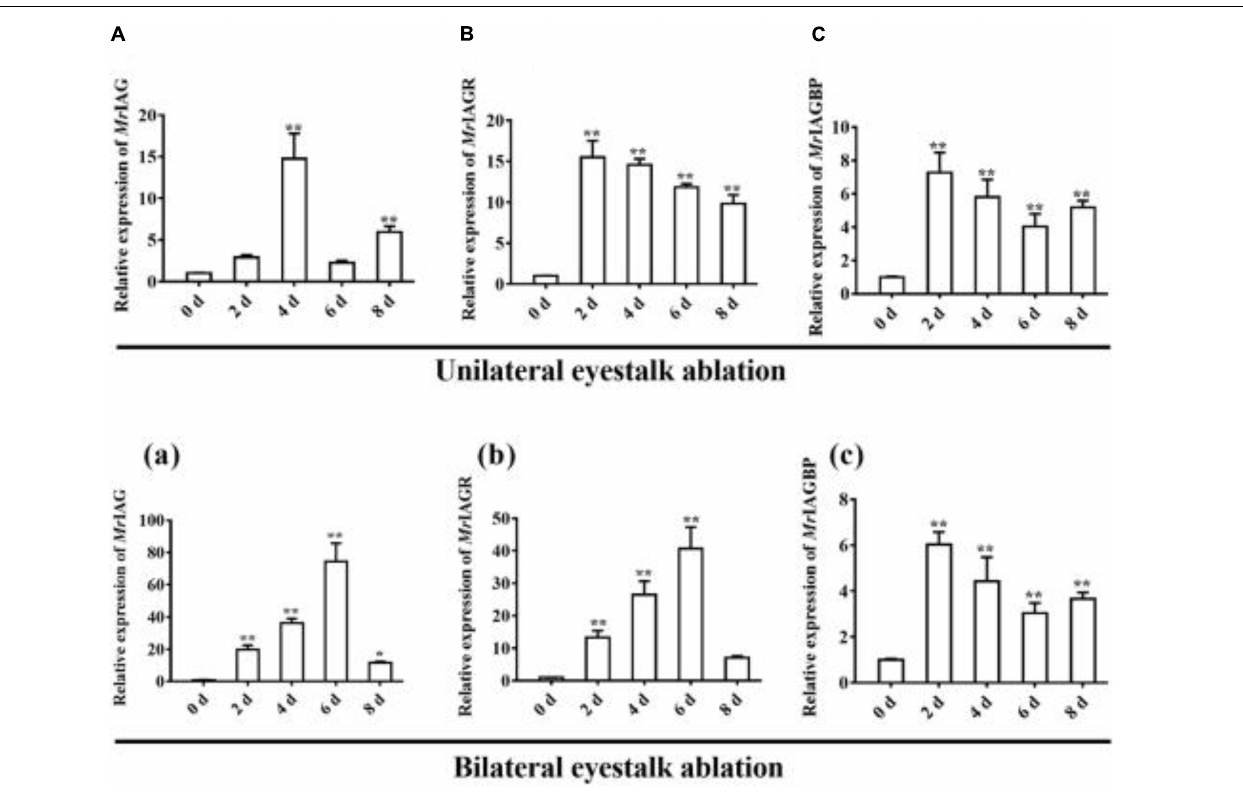
FIGURE 8 | Expression profile of IAG, IAGR, and IAGBP gene on different days in androgenic gland after eyestalk ablation. (A–C) unilateral eyestalk ablation, (A) Mr IAG, (B) Mr IAGR, ( C ) Mr IAGBP. (a–c) : bilateral eyestalk ablation, (a) Mr IAG, (b) Mr IAGR, (c) Mr IAGBP. Mr IAGBP was in red fluorescence signals. mRNA levels were analyzed by qRT-PCR and normalized to β -actin. qRT-PCR data are shown as means ± SD (standard deviation). * P < 0.05, ** P < 0.001.